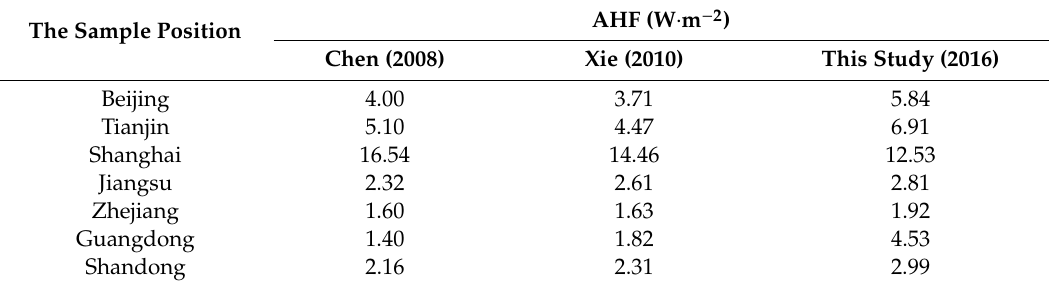
Table 2. Table 2. Comparison of AHF estimation results in this study with the existing AHF